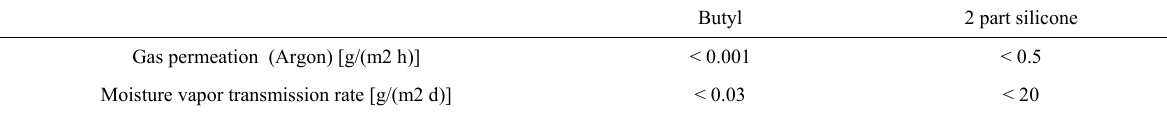
Table 1: Gas permeation and moisture vapor transmission of butyl vs. 2 part silicone Butyl 2 part